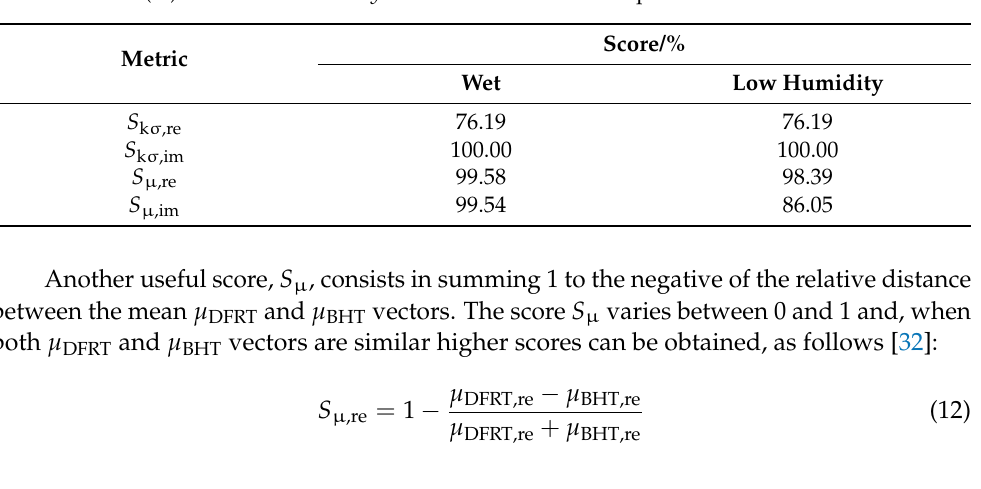
Table 2. Scores (%) obtained for the Bayesian Hilbert transform